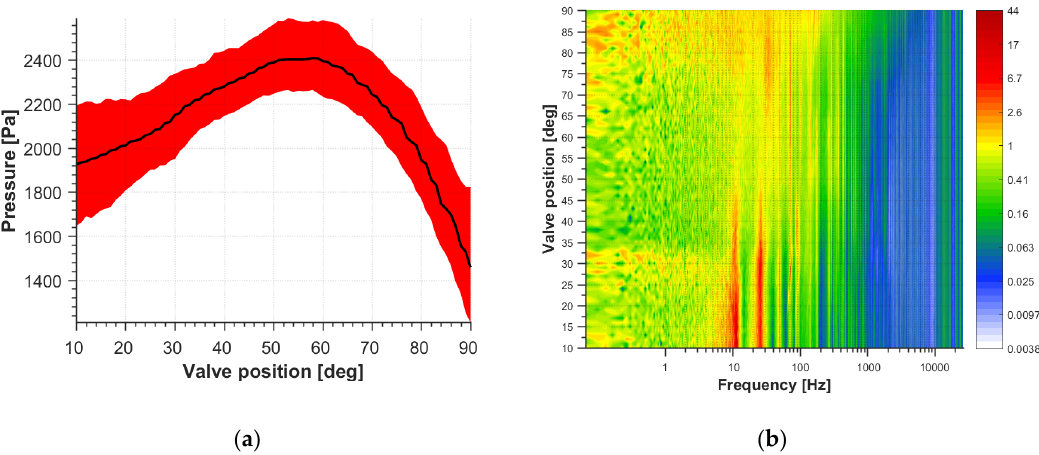
Figure 5. Pressure variation depending on the valve position measured at the outlet at impeller rotational speed 70 Hz. ( a ) The left plot represents the min-to-max plot (red) and the pressure average value (black). ( b ) The right plot represents the spectral map with the colormap in the logarithmic